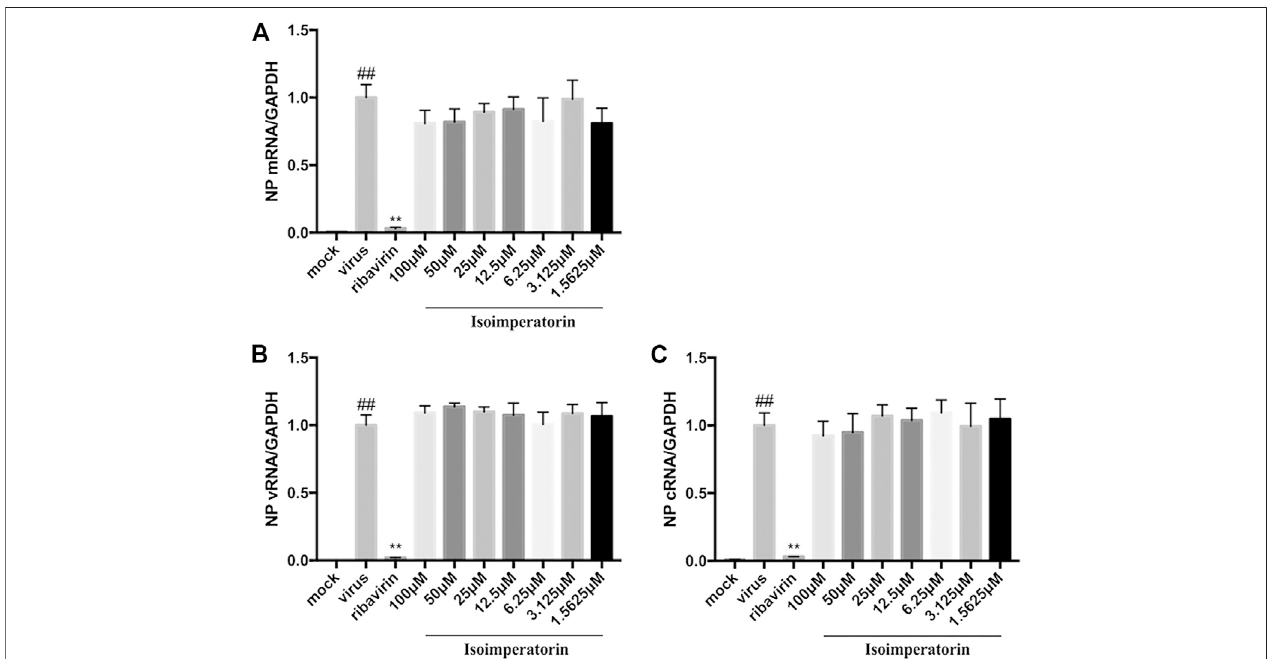
FIGURE 5 | Isoimperatorin has no effect on the replication of all three viral RNA species. (A) mRNA expression level. (B) vRNA expression level. (C) cRNA expression level. MDCK cells were infected with H1N1(A/PR/8/34) virus at 100 TCID50 and then treated with DMSO control, ribavirin control (35.5 μ M), or various concentrations of isoimperatorin at 2 hpi. Total RNA was collected at 6 hpi, and viral RNA levels were quanti fi ed by real-time RT-PCR. The RNA expression level of the DMSO control group (0 μ M) was set as 100%. Data are representative of three independent experiments (mean ± SEM). Statistical signi fi cance was analysed by one-way ANOVA. # P < 0.05, ## P < 0.01, relative to the mock control group. * P < 0.05, ** P < 0.01, relative to the virus